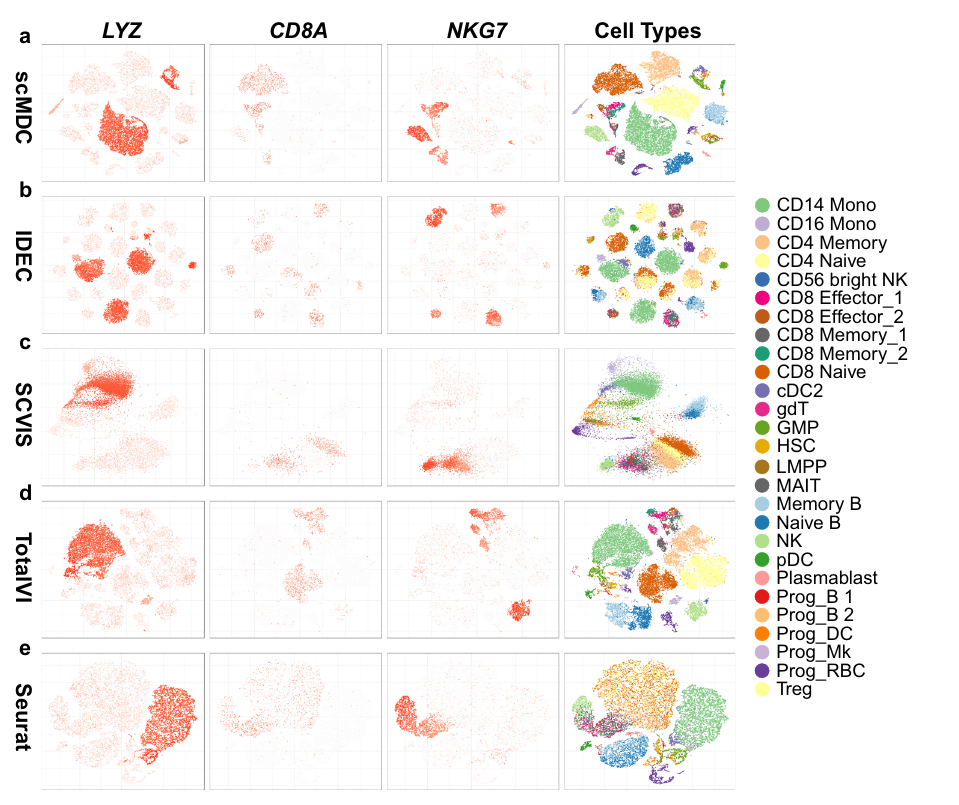
Fig. 5 | Low-dimension representation of scMDC and the competing methods ontheBMNCdataset. Thet-SNEplotsoftheembeddingsfromscMDC( a )andfour competing methods including IDEC ( b ), SCVIS (c), TotalVI ( d ), and Seurat ( e ) are